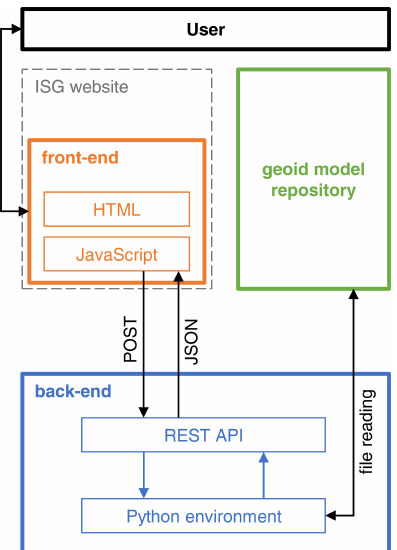
Figure 5. Logical structure of the height conversion web